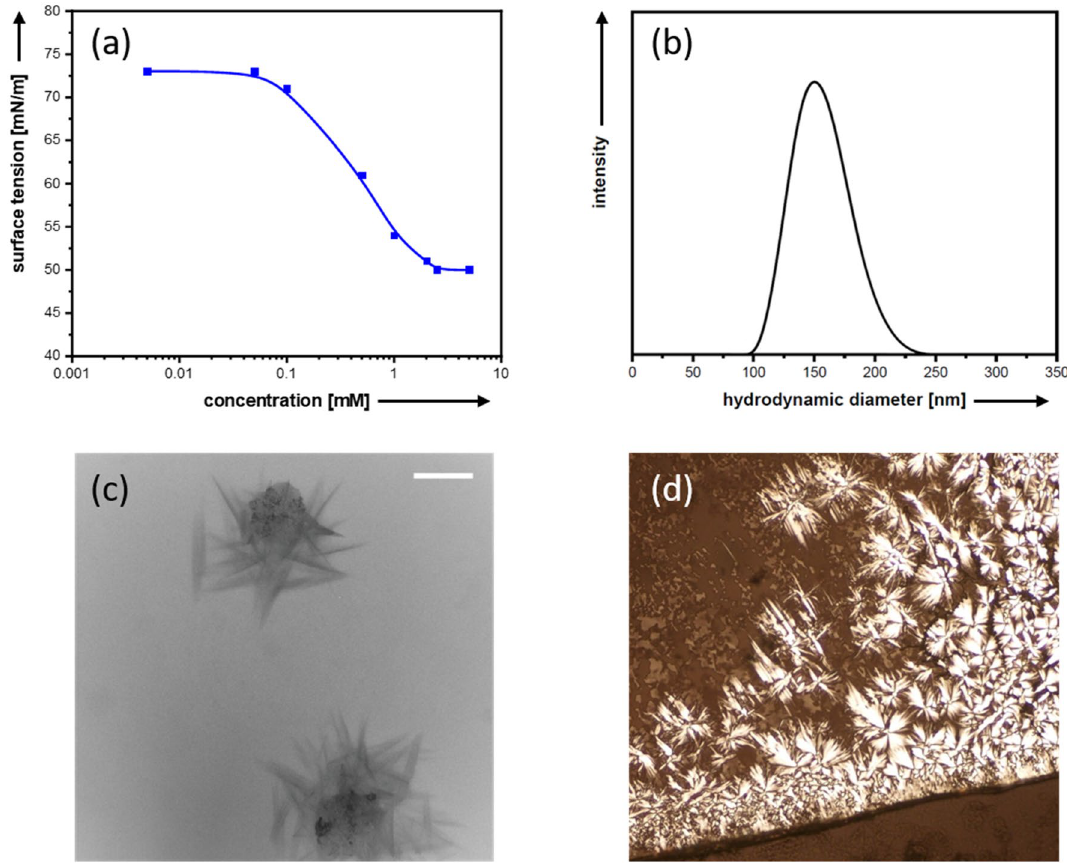
Figure 4. Surfactant-like behavior of Sc-DO3A-C 11 -SH in water. Concentration dependent surface tension ( a ), DLS size distribution function ( b ) representative TEM image of a dried solution ( c ; scale bar = 100 nm), microscopy image of a high concentration phase under crossed polarizers ( d